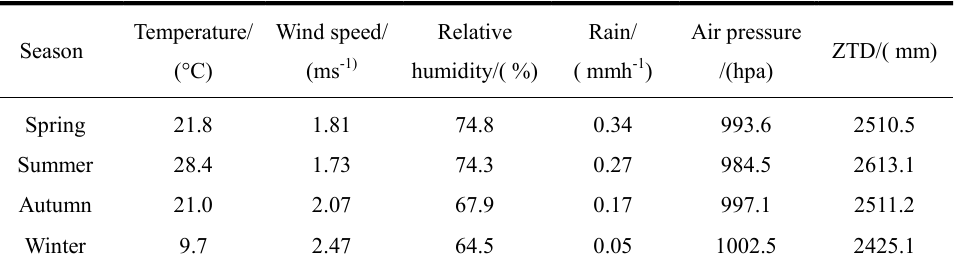
Tab.3 Gray correlation between PM